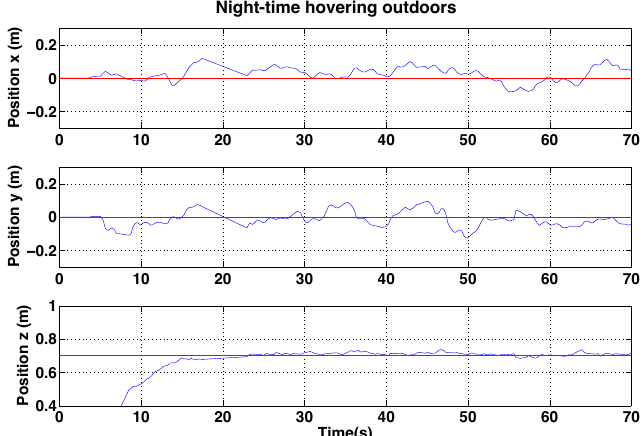
Figure 32. Experimental results for IBVS-based hovering: control performance for night-time IBVS-based hovering. Goal positions shown in